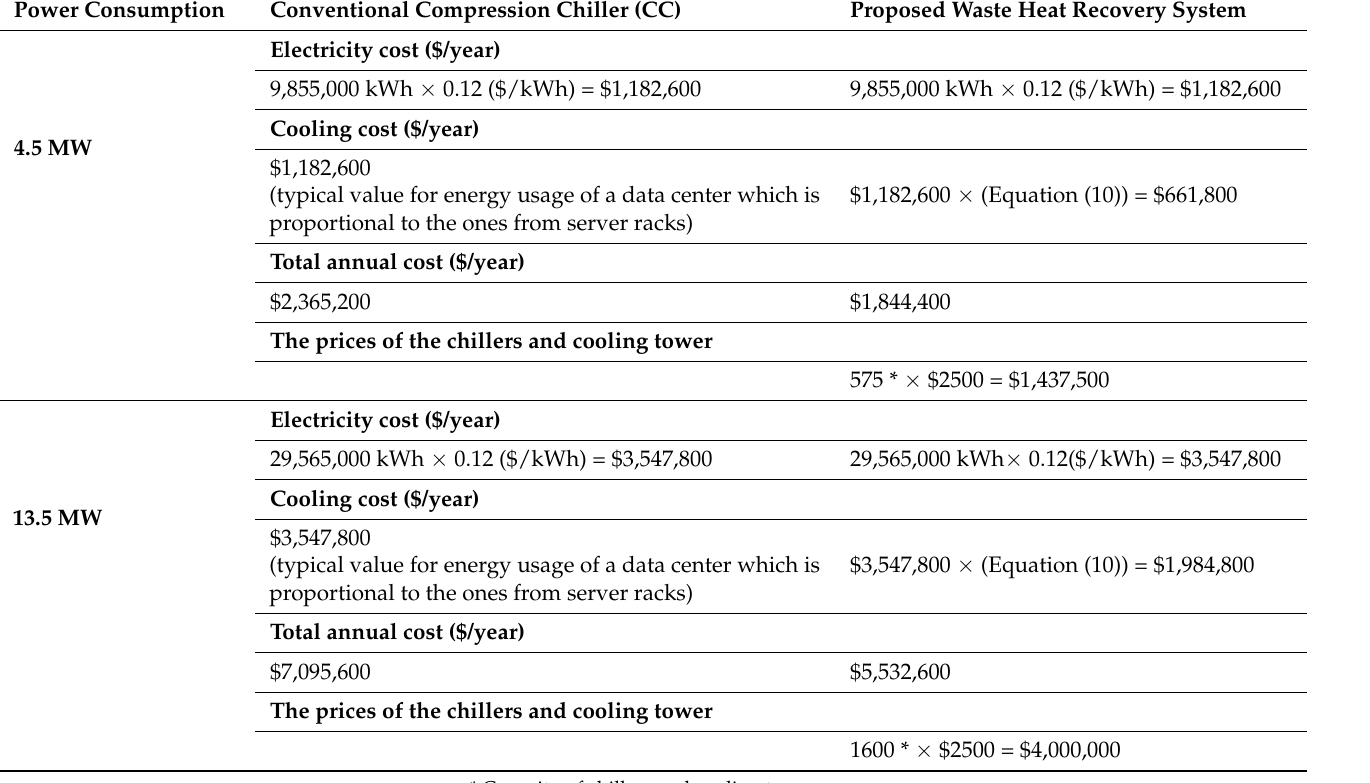
Table 2. Economic analysis for a 4.5 and 13.5 MW data center comprising 300 and 900 server racks with chillers of 575 ton and 1600 ton